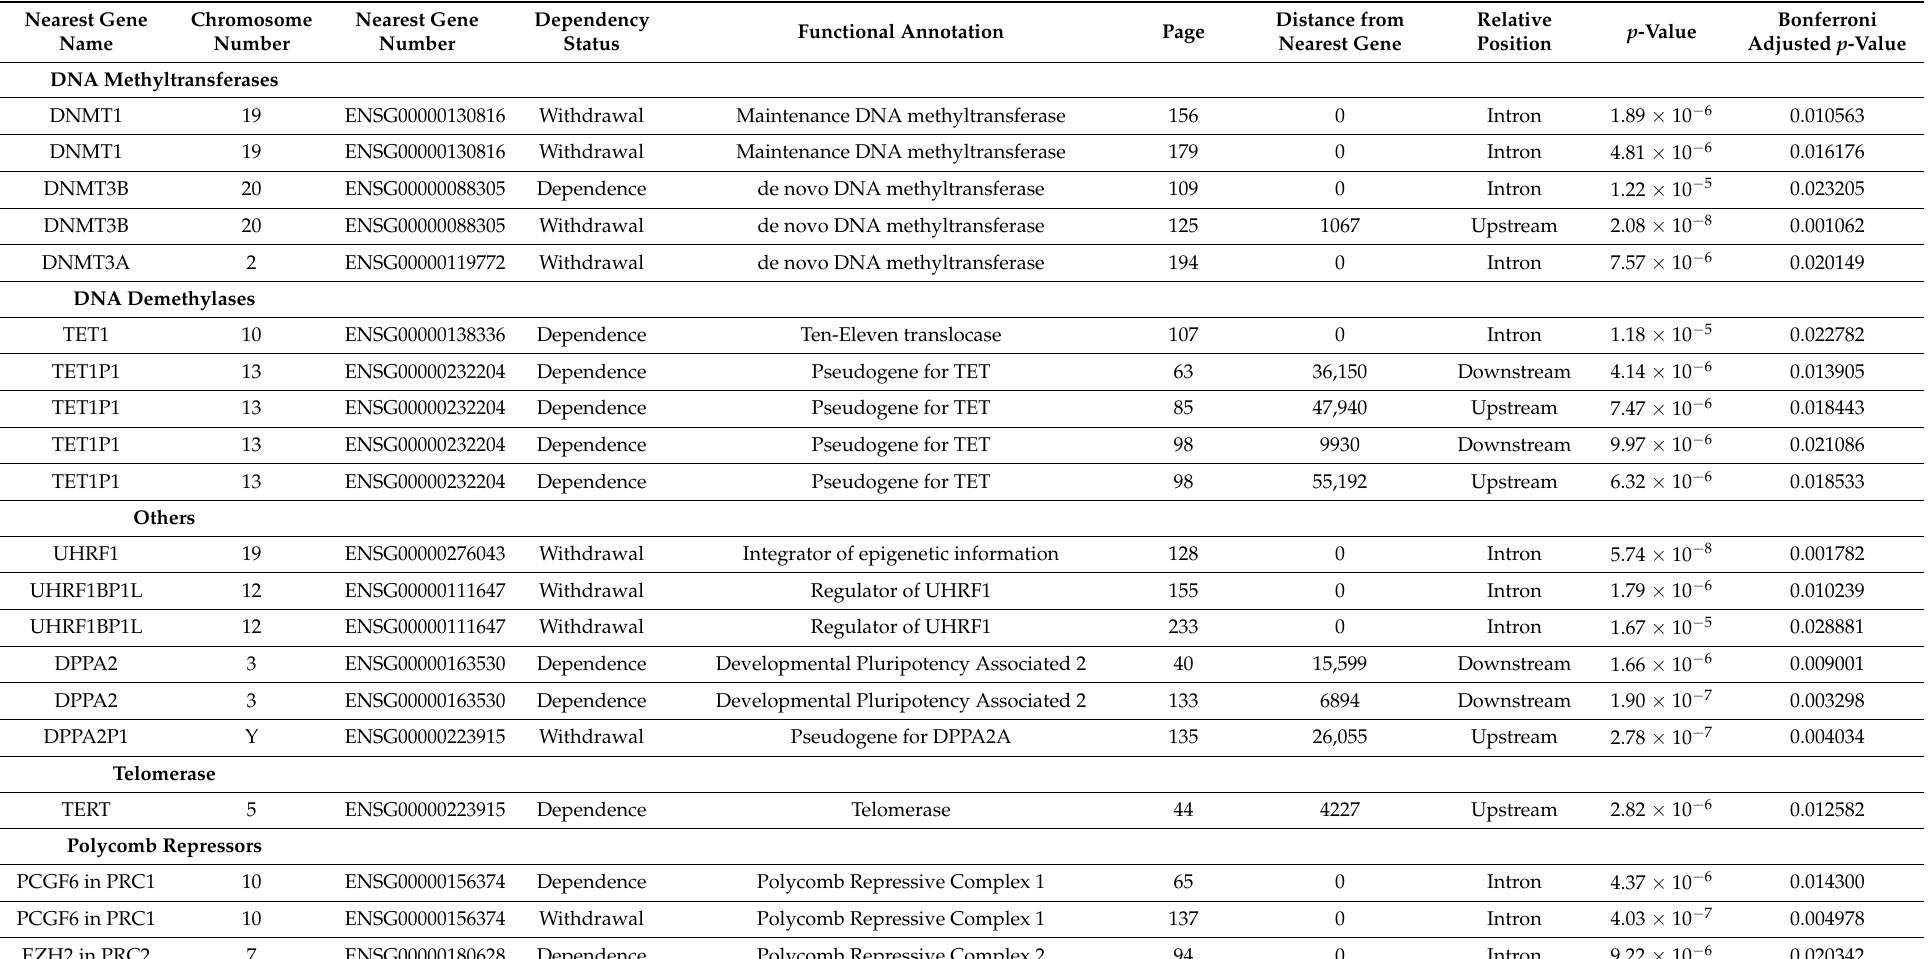
Table 2. Overview of Cannabis Impacts on Epigenetic Machinery, Schrott EWAS